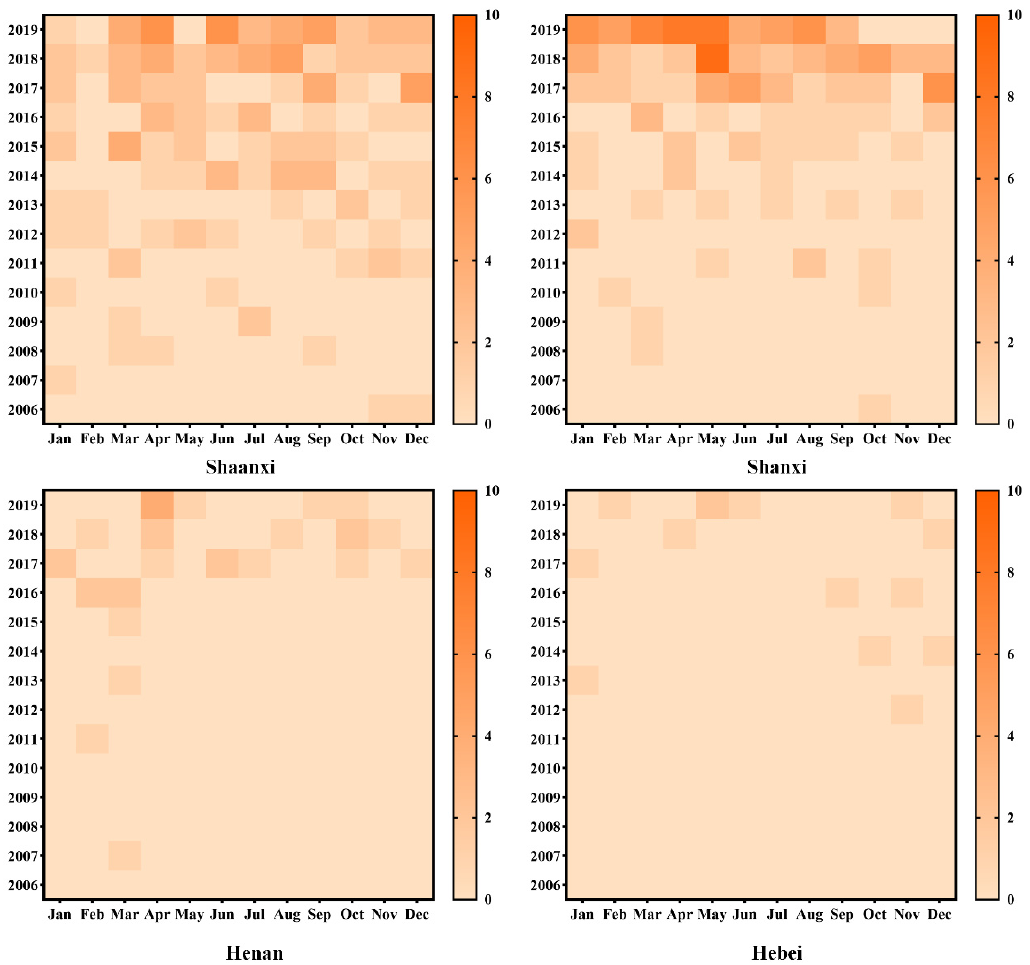
Figure 3. The interannual variability in the number of VL cases in central China (Shaanxi, Shanxi, Henan, and Hebei) from 2006 to 2019.